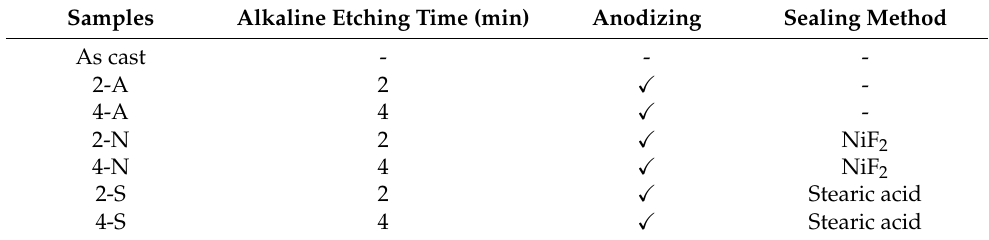
Table 3. Notations of samples with different pretreatments and sealing methods. Samples Alkaline Etching Time (min)